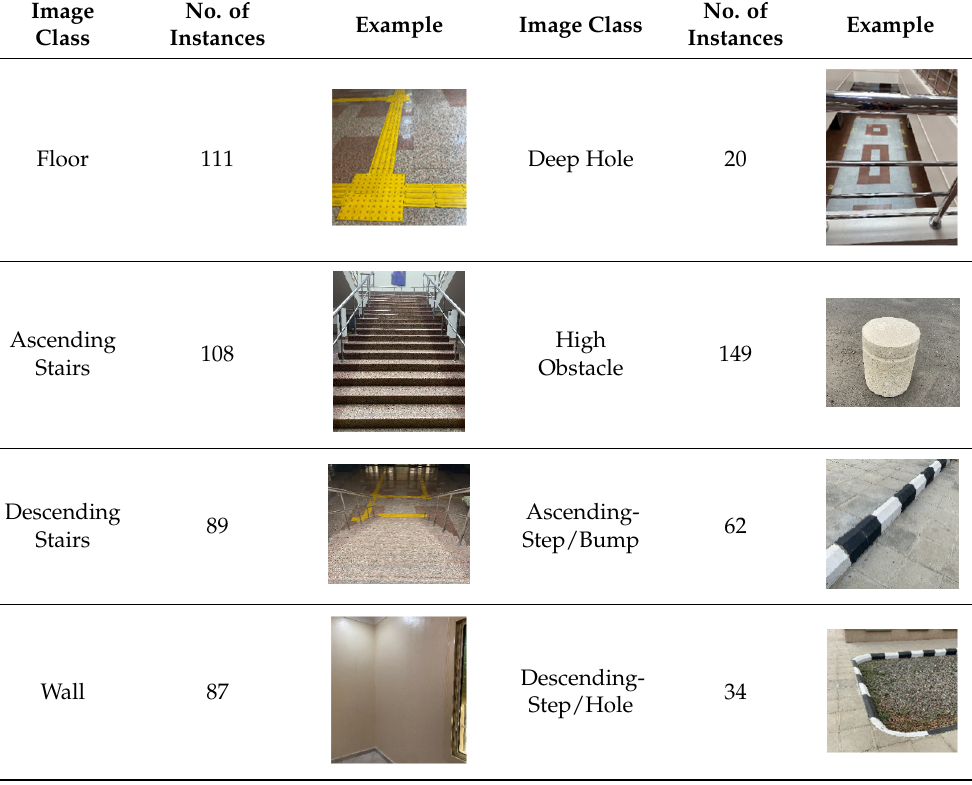
Table 4. Preprocessing and Feature